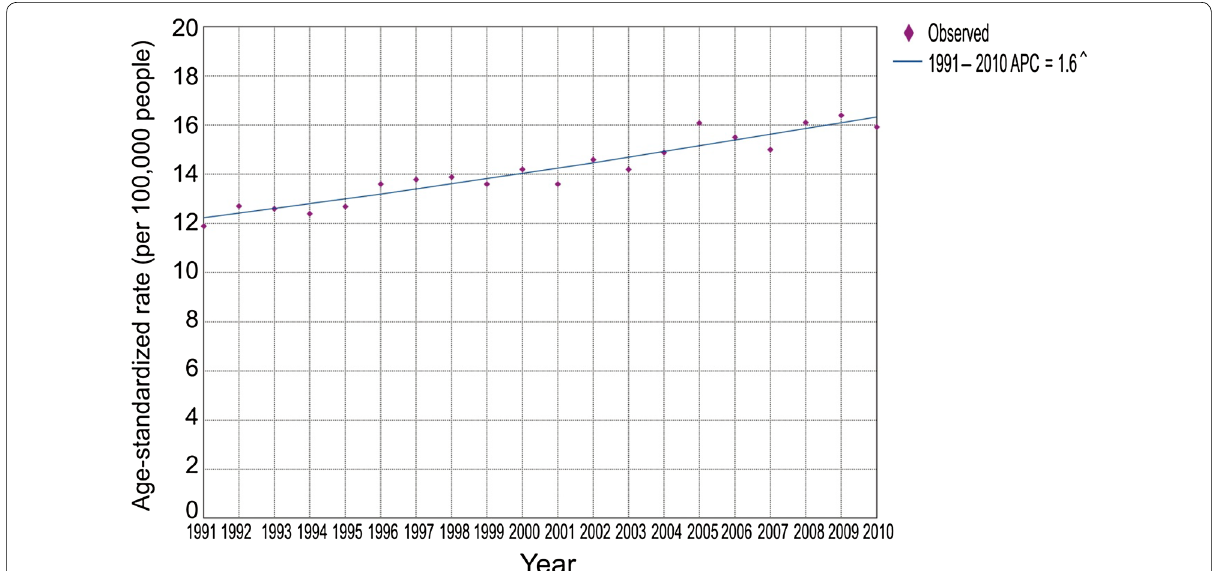
Fig. 1 Trend in mortality of colorectal cancer in Serbia during the period 1991–2010: a joinpoint regression analysis. ^ Statistically significant trend, APC average percentage change